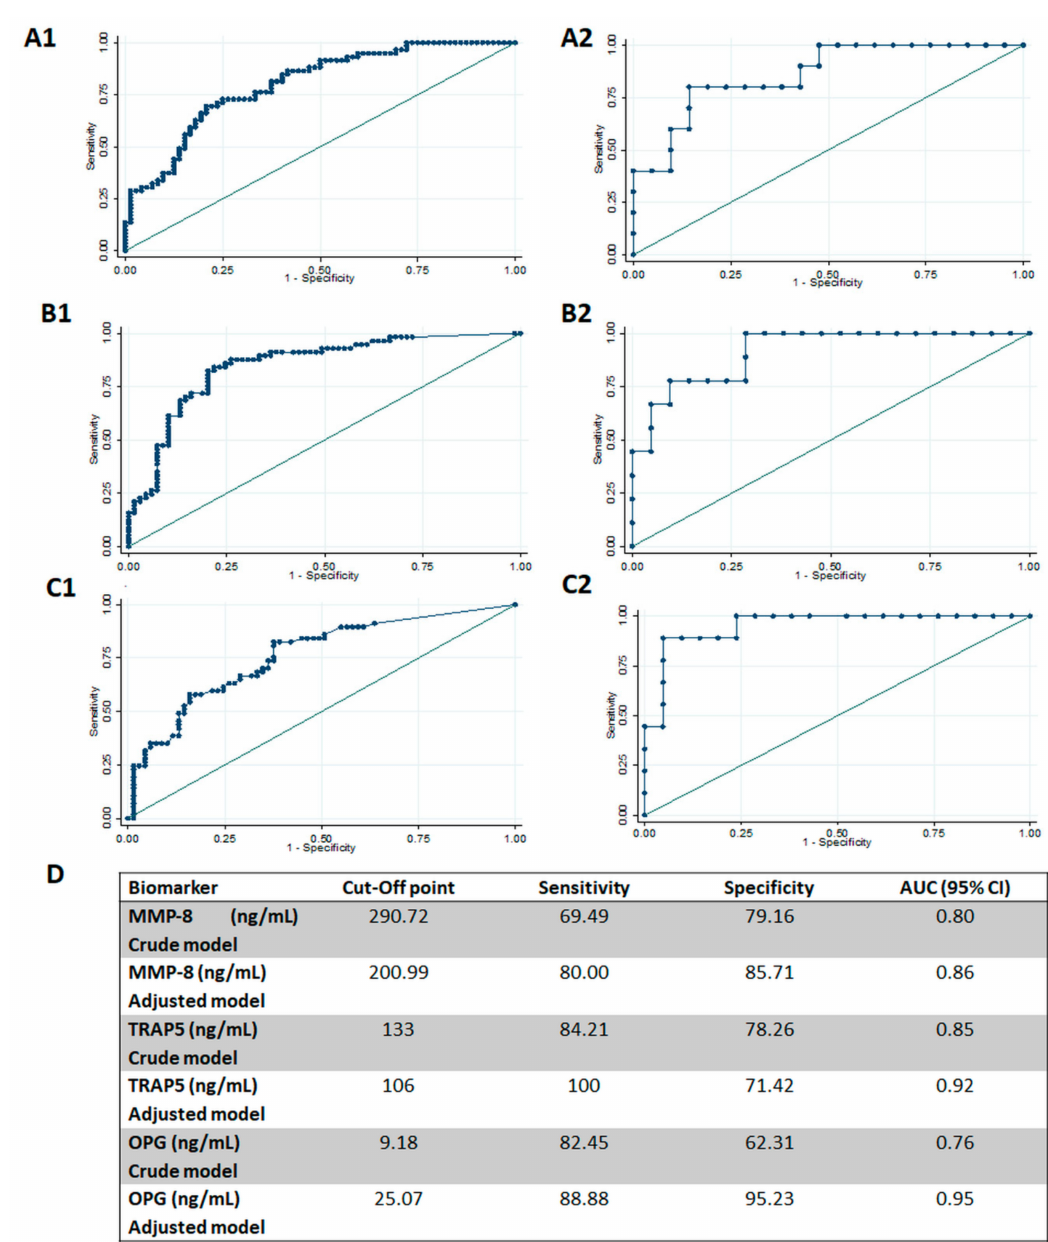
Figure 2. Diagnostic potential of biomarkers to identify severe periodontitis sites. ( A ). Crude ( A1 ) and adjusted models ( A2 ); ( B ). diagnostic potential of TRAP5 to identify healthy from periodontitis sites, crude ( B1 ) and adjusted ( B2 ); ( C ). diagnostic potential of OPG to identify healthy from periodontitis sites, crude ( C1 ) and adjusted ( C2 ); ( D ). sensitivity, specificity, and cut-o ff points of MMp-8, TRAP5, and OPG in their diagnostic potential to identify healthy from periodontitis sites. AUC: area under de curve. CI: confidence interval. MMP-8: matrix metalloproteinase-8, TRAP5: tartrate-resistant acid phosphatase-5, and OPG: